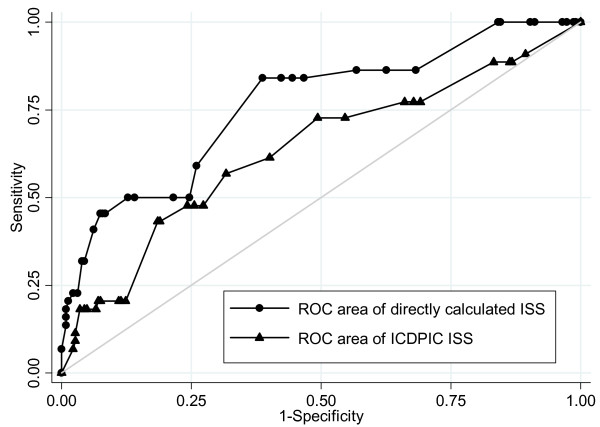
ROC curves for prediction of survival of the 2 scores. ROC area of directly calculated ISS: 0.7631, 95% CI 0.68-0.84. ROC area of ICDPIC ISS: 0.6355 95% CI 0.53-0.73. ISS = Injury Severity Score.